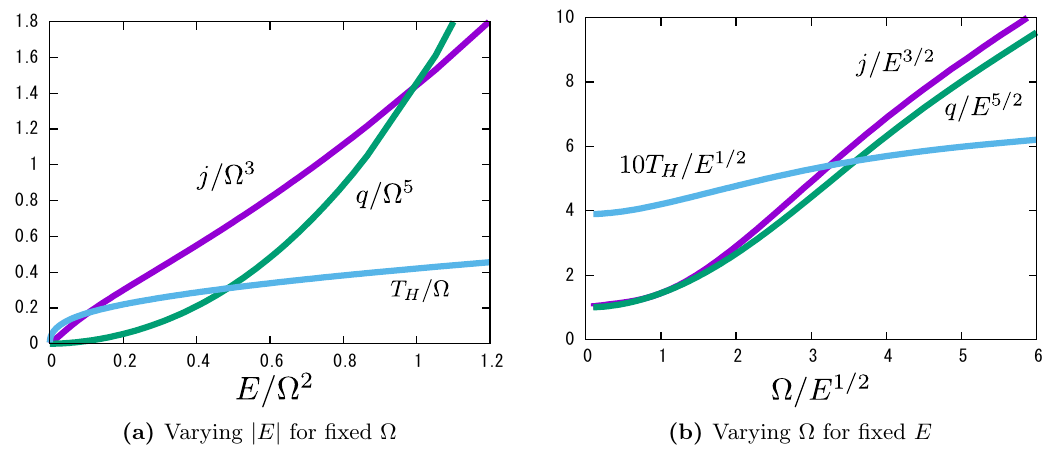
Figure 5. Electric current, Joule heating and Hawking temperature. They are increasing functions of E and (cid:10) for (cid:12)xed (cid:10) and E , respectively. In the right (cid:12)gure, we multiply 10 to Hawking temperature T H for